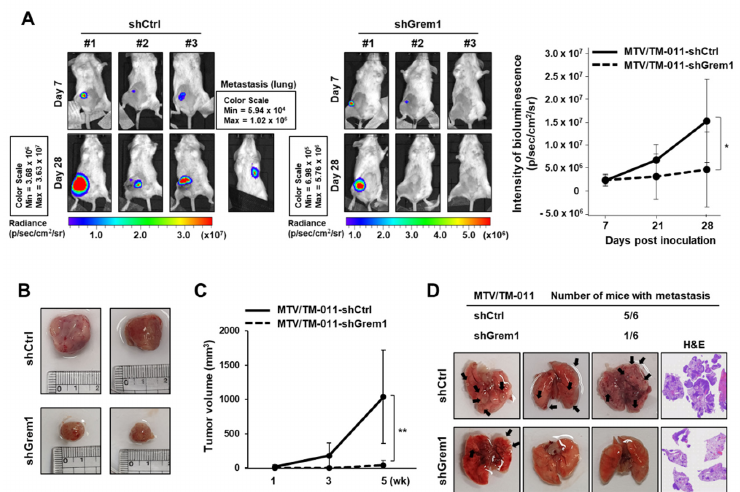
Figure 4. GREM1 promotes lung metastasis of breast cancer cells in vivo . ( A ) MTV/TM-011-shCtrl-luc or MTV/TM-011-shGrem1-luc cells were inoculated directly into the fourth mouse mammary fat pad of anesthetized BALB/c mice ( n = 6/each group). Bioluminescence images of mice were captured at day 7 and day 28 after cell inoculation. ( B ) Representative images and ( C ) tumor volume of primary tumors in mice inoculated with each cell line. ( D ) Representative images of lung metastatic foci and hematoxylin and eosin staining. Black arrowheads indicate prominent lung metastatic foci. Two-sided t -test. *, p < 0.05; **, p <